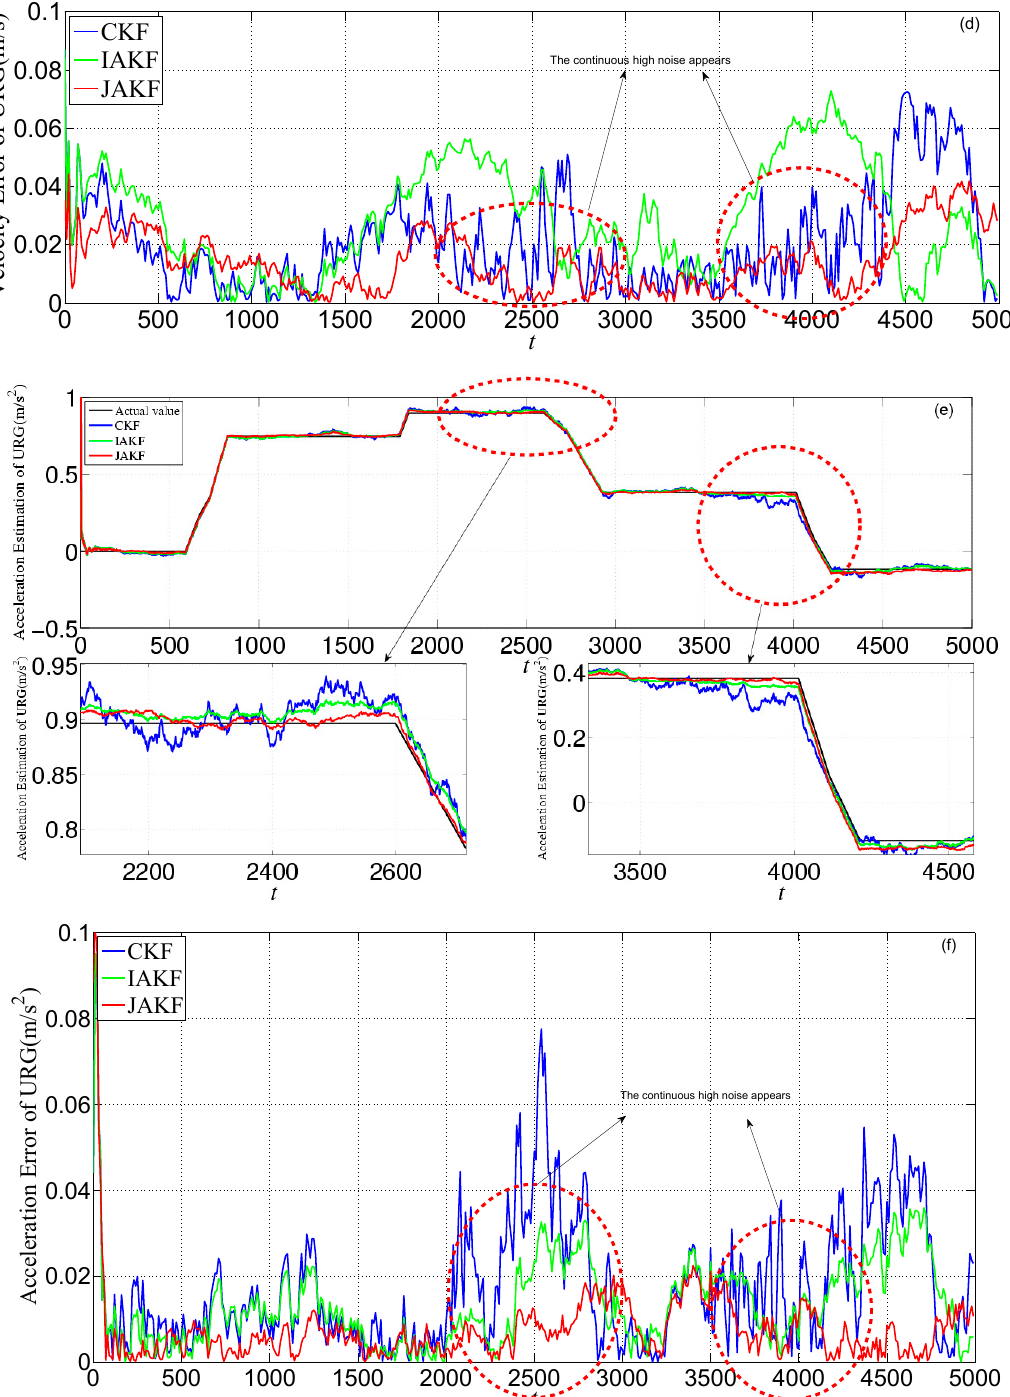
Figure 14. Estimation and error comparison of URG in the second experiment: ( a ) Displacement estimation of URG; ( b ) Displacement error of URG; ( c ) Velocity estimation of URG; ( d ) Velocity error of URG; ( e ) Acceleration estimation of URG; ( f ) Acceleration error of URG.